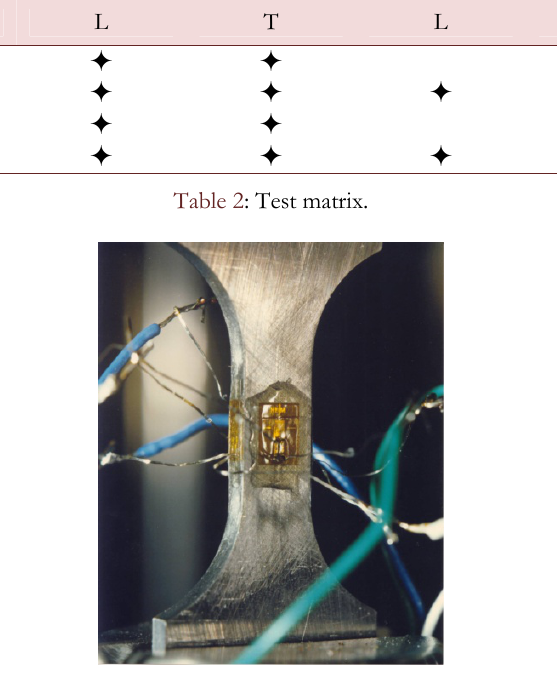
Figure 8: Specimen (B) during tensile